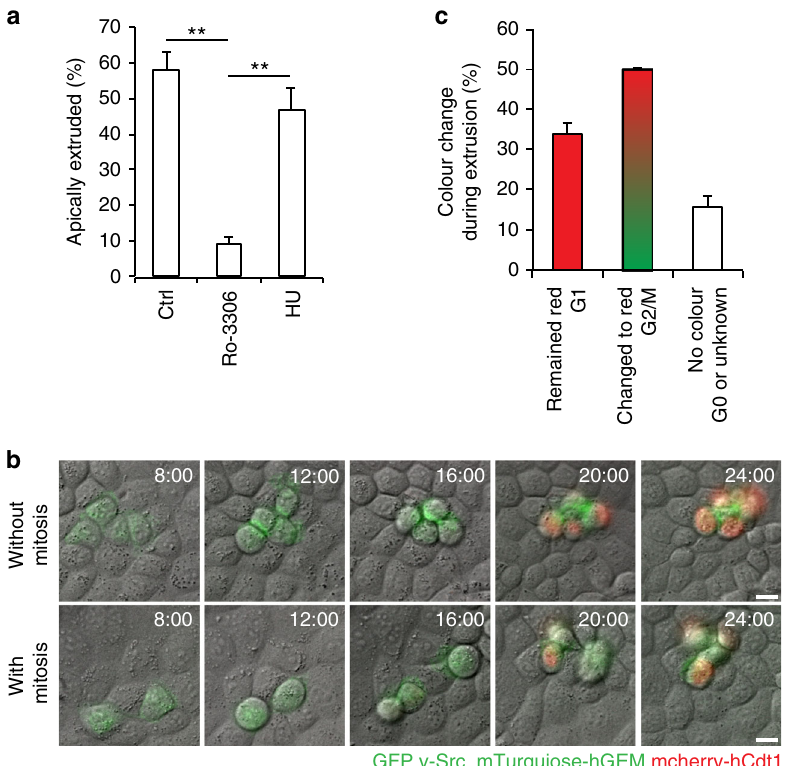
Fig. 5 Majority of Src-transformed MDCK cells extrude during or instead of mitosis. a The effect of inhibition of the G2/M transition or G1/S transition on extrusion of MDCK-pTR-cSrc-Y527F from a monolayer of normal MDCK cells. Inhibitors 2 mM hydroxyurea or 10 µ M Ro-3306 were added with a 9-hour delay after the induction of Src-expression. At 24 h from Src induction cells were fi xed, stained with phalloidin and imaged. Data are mean ± s.d. of three independent experiments (total number of cells: n Ctrl = 155; n HU = 153; n Ro3306 = 152). ** P < 0.005 (Student ’ s t -test). b Time-lapse imaging over 24 h of extrusion of MDCK stably expressing both pTR-cSrc-Y527F-GFP and FUCCI. GFP-CAAX labels Src cells (green membrane) that express Cherry-hCdt1 in G1 phase (red nuclei) or mTurquoise-hGEM in S/G2/M phases (green nuclei). c Quanti fi cation of the nuclear colour change in MDCK-pTR-cSrc-Y527F- GFP/FUCCI cells during extrusion based on live-imaging. Data are mean ± s.d. of two independent experiments (total number of extruded cells: n =